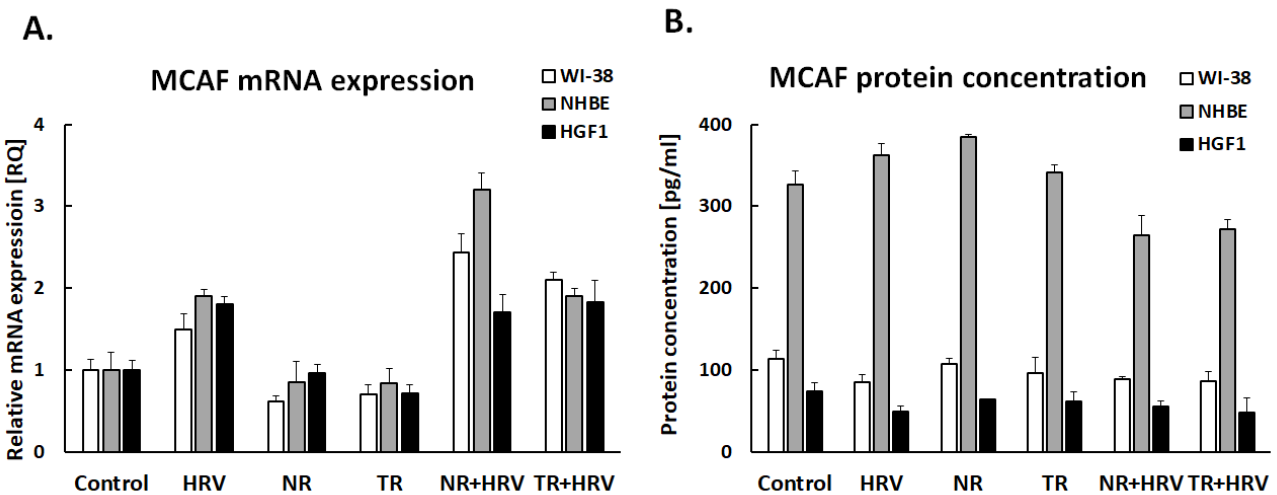
Figure 4. The effect of the Leonotis nepetifolia NR and TR root extracts and viral infection (HRV-16) on the expression of GM-CSF on mRNA ( A ) and protein ( B ) levels in human cells. Data presented as mean ± SEM, * p < 0.05.